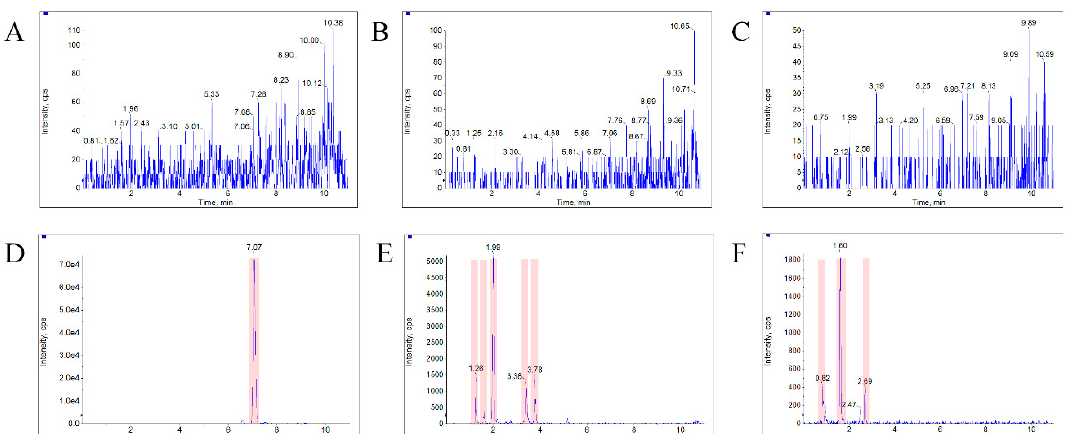
Figure 4. The typical MRM chromatograms of metabolites. ( A ), ( B ), and ( C ) represent the metabolites’ m / z 387.4–369.6, 403.25–349.22, and 419.24–365.21 in blank plasma, respectively. ( D ), ( E ), and ( F ) represent the three metabolites in a plasma sample from a rat with a single dose of 10 mg/kg bufalin.